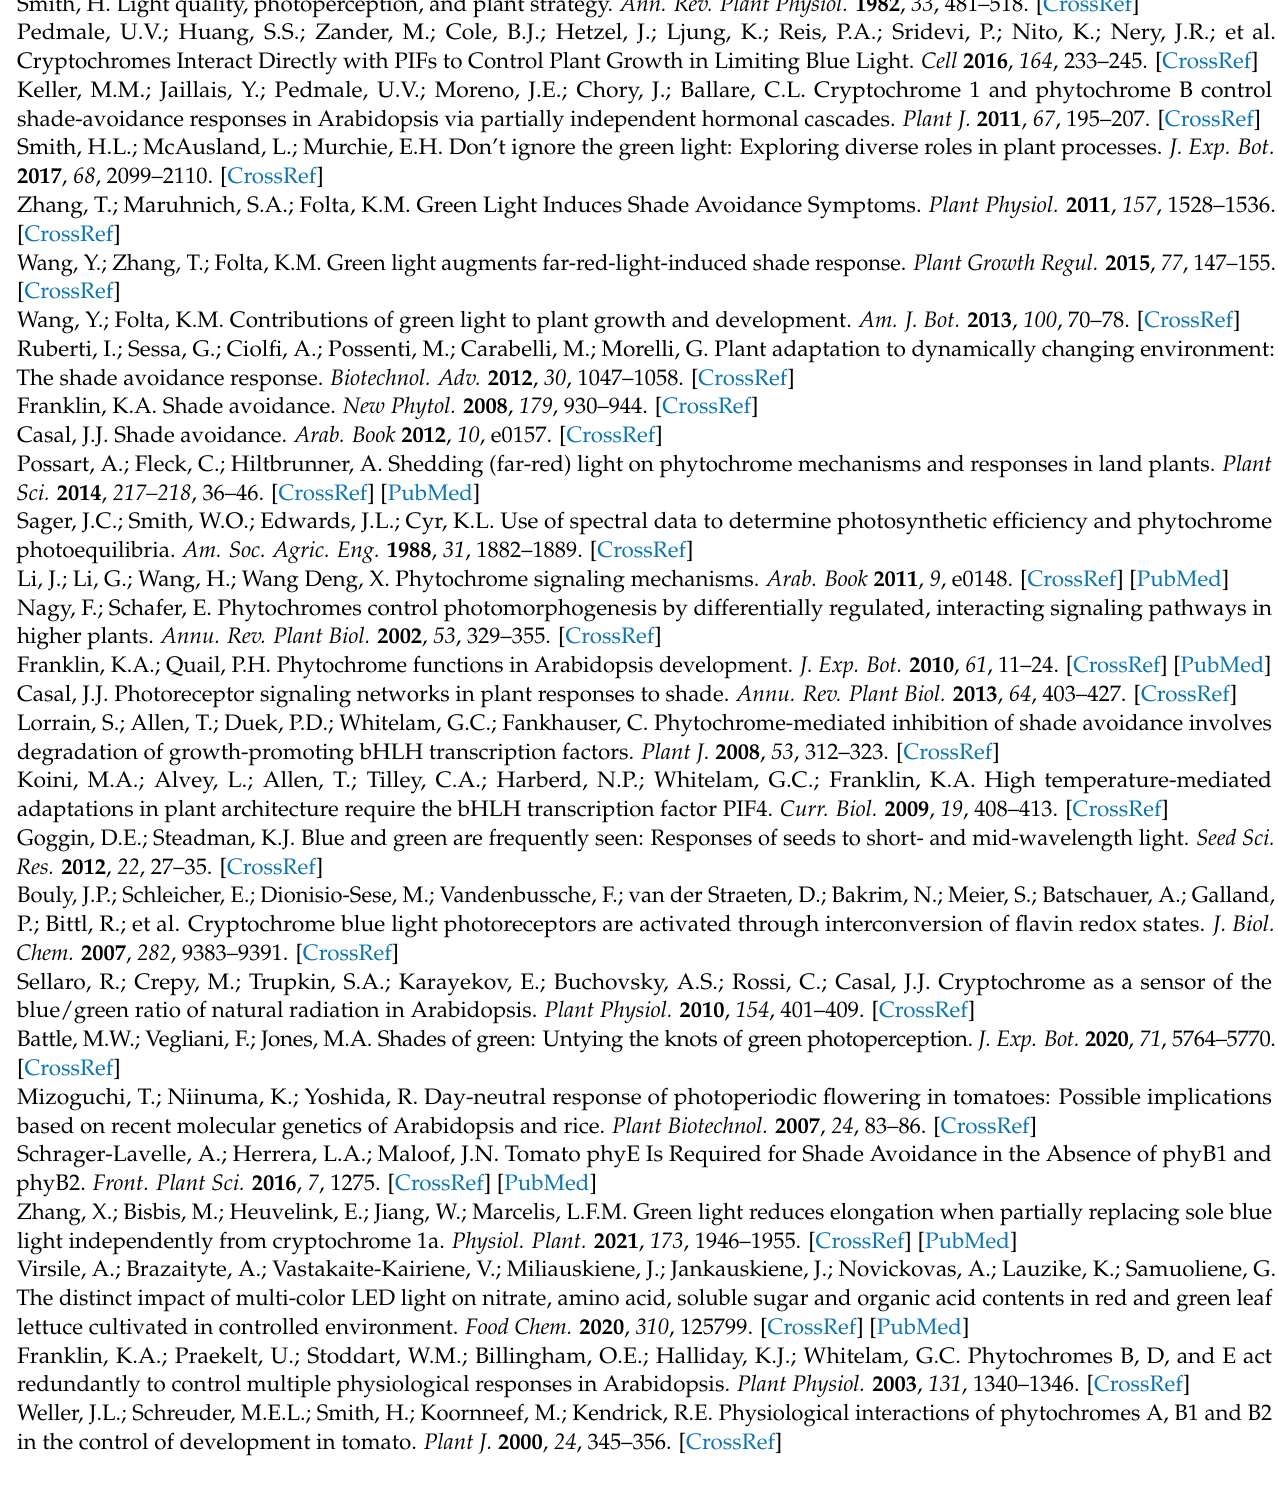
A-deficient), ( C ) phyB1B2 (phytochrome B1- and B2-deficient), and ( D ) phyAB1B2 (phytochrome A-, B1-, and B2-deficient). Light treatment and genotype did not significantly interact ( p = 0.249), but the effects of genotype were significant ( p < 0.001). Lower case letters indicate significant differences among the combinations of light treatment and genotype ( p = 0.05), thus allowing comparisons between panels ( A – D ). Data presented are averages, with the SE based on 5 blocks ( n = 5), each containing 3 replicate plants